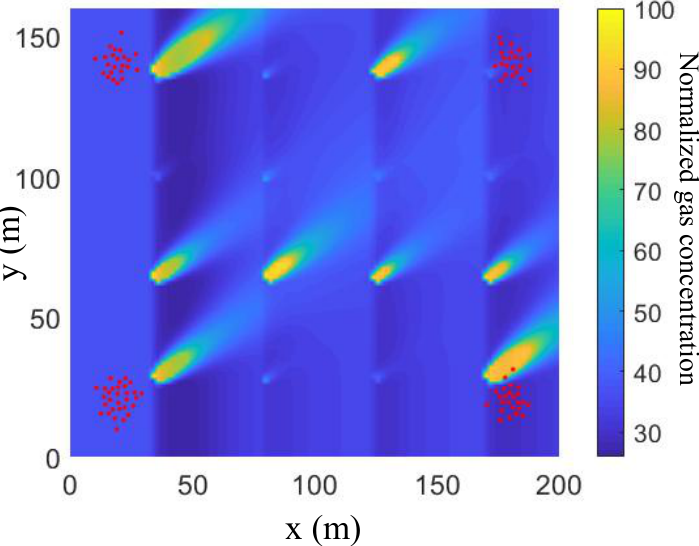
Figure 4. ROI and Gas concentration distribution in an outdoor environment and initial robot deployment in the ROI, where the red points represent the robots.